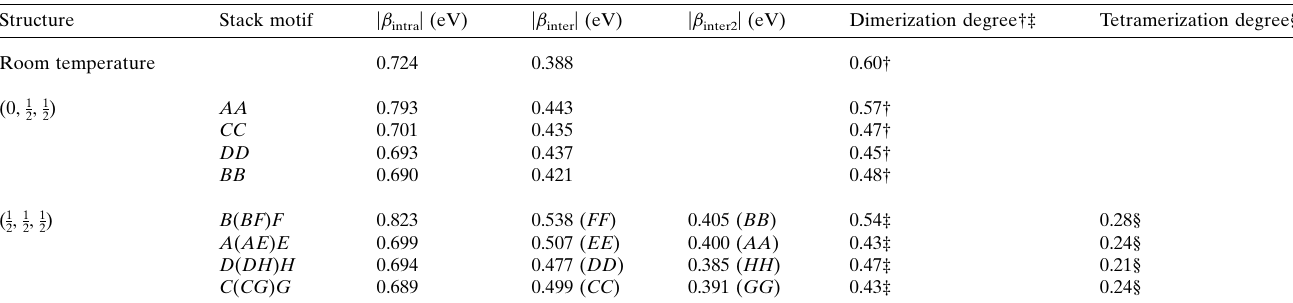
Table 2 Calculated overlap interaction energies within the stacks in ( o -Me 2 TTF) 2 NO 3 in the different phases. In the low-temperature ( 1